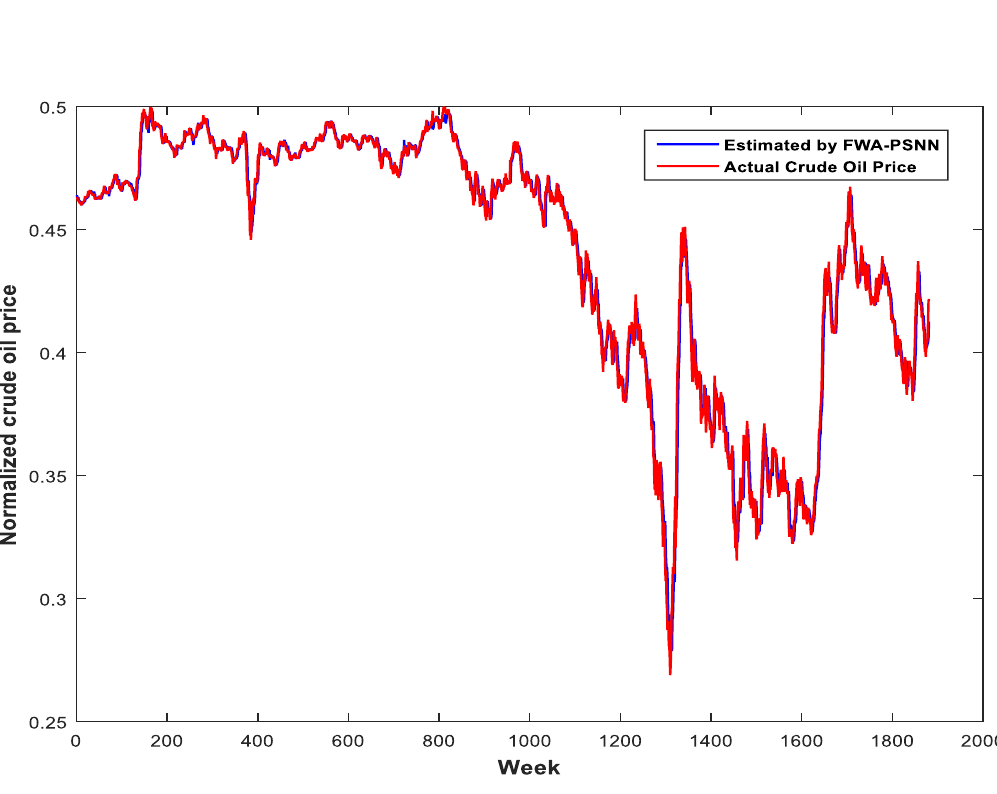
Figure 7. Actual crude oil prices v/s estimated by FWA-PSNN from weekly crude oil price time series